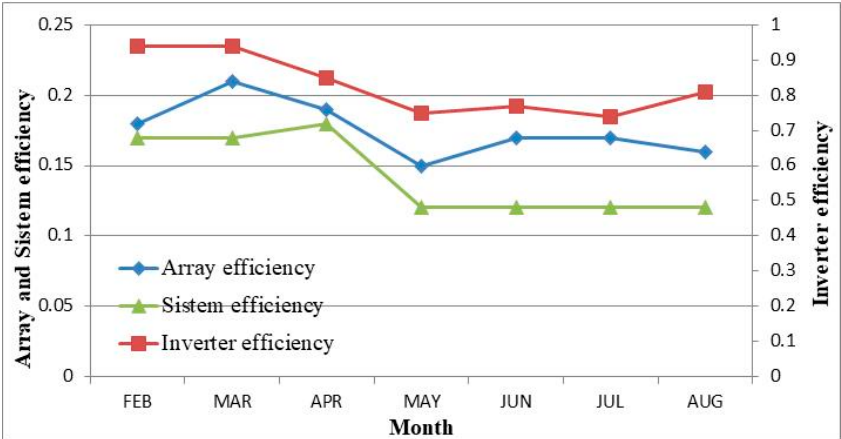
Figure 9. Average array, system and inverter efficiencies.